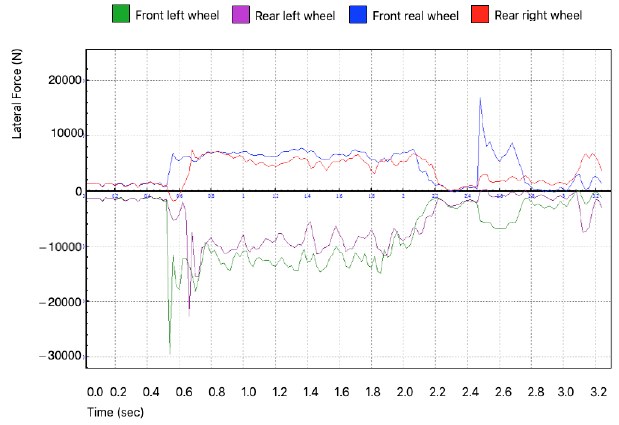
Figure 14. Total lateral force for a conventional deflection.